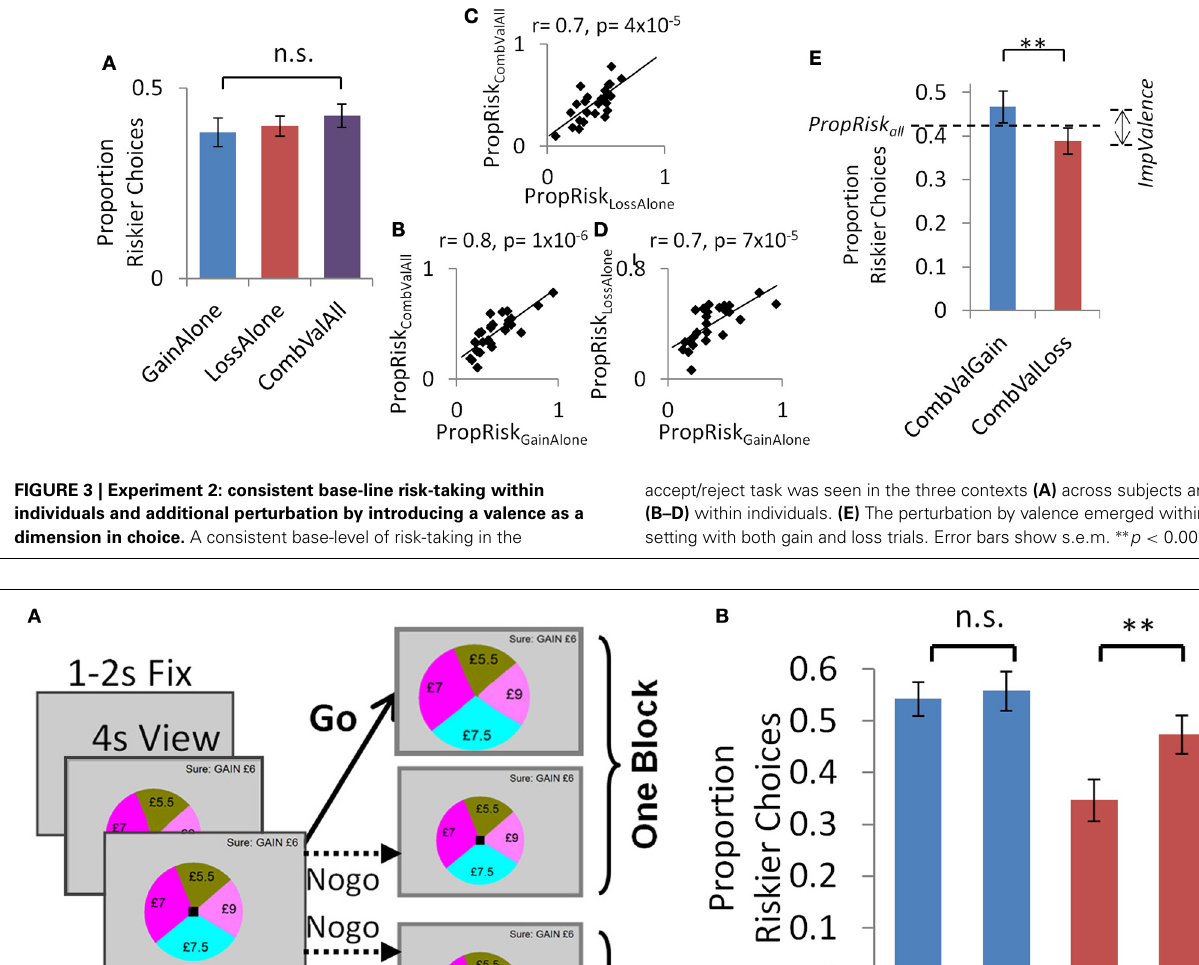
FIGURE 4 | Experiment 3a: go-nogo manipulation in the accept/reject task. (A) Trials were identical to the accept/reject task above, except here participants could either go (button press) or nogo (no button press). In one block (GoRiskier), participants had to go to accept the risky option or nogo to reject. In the other block (NogoRiskier),